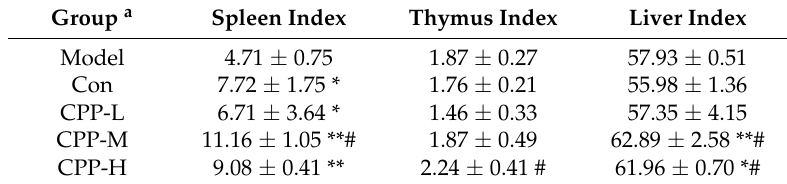
Table 1. Effects of CPP on spleen, thymus and liver index in cyclophosphamide-treated mice. Group a Spleen Index